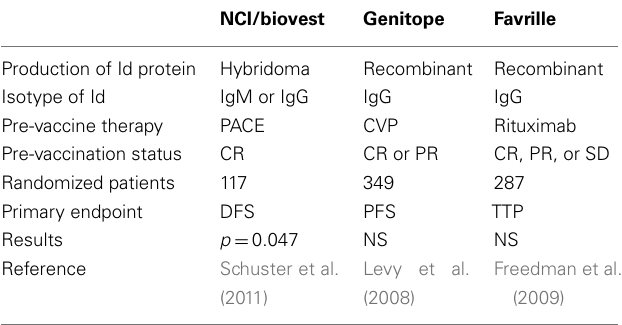
Table 3 | Phase III clinical trials of Id vaccination in follicular